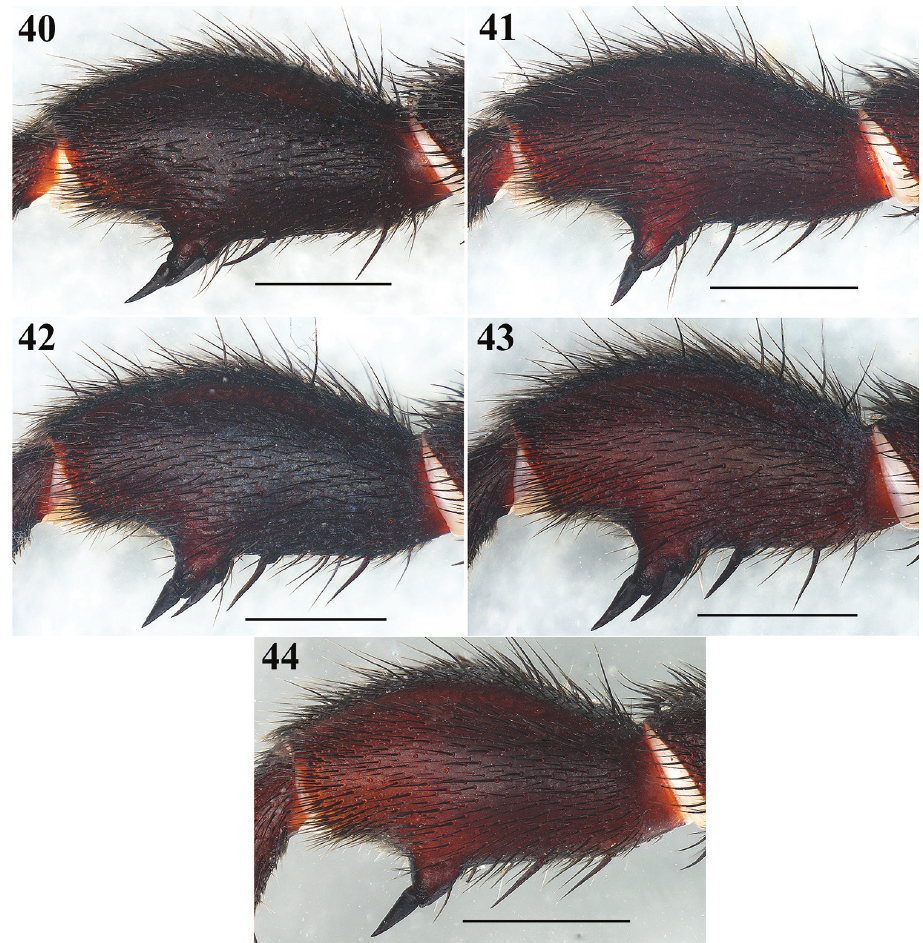
Figures 40–44. Eucteniza zapatista Bond & Godwin, 2013. Male: Morphological variation in the shape of the tibia I and macrospines of the five males collected for this study. Scale bars 2 mm. 18–20 small denticles. Rastellum consisting of 6-8 spines on a mound. Opisthosoma: Longer than wide, setose, gray, without pattern dorsally; lighter gray ventrally (Figs 21, 22). Spinnerets beige (Fig. 27). PMS small and rounded, single segment, with spigots. PLS long and conical, all 3 segments with spigots: basal segment length > median seg- ment > distal segment. Legs: Very light tarsal scopulae on legs I, II, III (Fig. 39), absent in IV. Tibiae, metatarsi and tarsi with trichobothria, lacking pattern, only tarsi with slightly staggered dorsal row, variable in number. Legs spination pattern: Tibia I: with paired ventral megaspines (Figs 32, 33, 36) on prominent base (Fig. 38); tibiae II: with 1 thin and long megaspine (Figs 34, 35) on a slender base (Fig. 37); tibiae III and IV: scattered long spiniform setae; metatarsi and tarsi with scattered spination pattern. Pedipalps: Articles setose. Femora brown, long and cylindrical. Patellae brown,